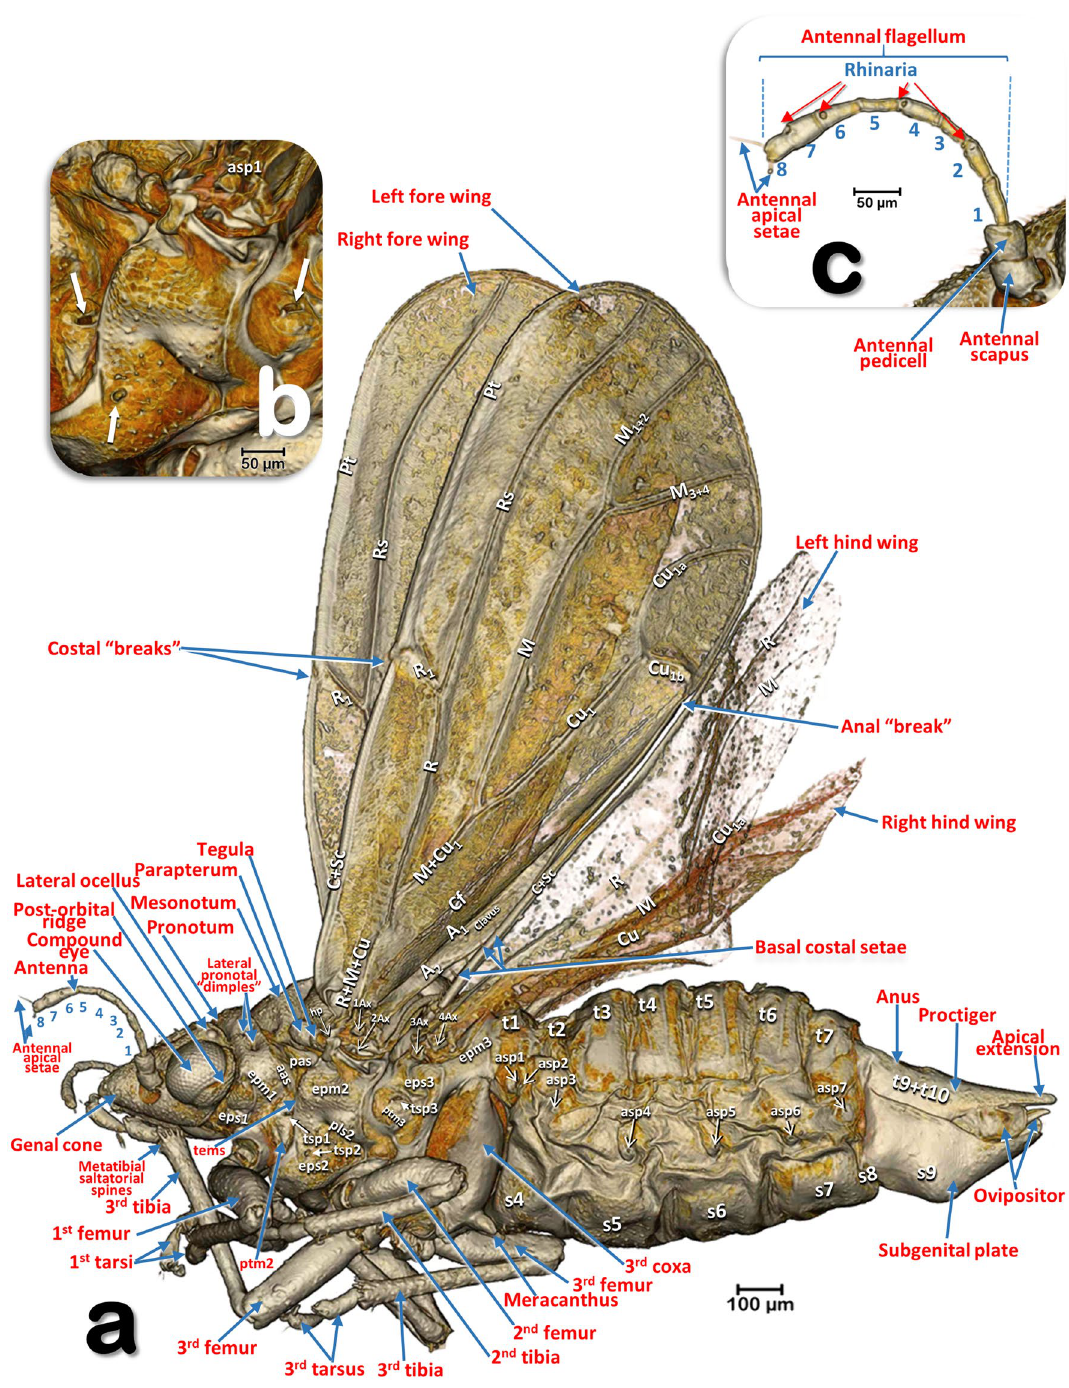
Figure 3. Volume-rendered images of an external left-lateral detailed view of a female Diaphorina citri ( a ) and a close-up detail of the pleural region of the thorax ( b ) (arrows indicate the spiracular openings), and the antenna ( c ). Abbreviations: A = anal vein; aas = anterior accessory sclerite; asp = abdominal spiracle; Ax =Axillary sclerite; C = costa vein; Cf = cubital fold; Cu = cubital vein; epm = epimeron; eps = episternum; hp = humeral plate; M = median vein; pas = posterior accessory sclerite; pls = pleural sulcus; Pt = pterostigma; ptm2 = mesothoracic peritreme; ptm3 = metathoracic peritreme; R = radius vein; Rs = radial sector vein; s = abdominal sternite; t = abdominal tergite; tems = transepimeral sulcus; tsp1 = prothoracic spiracle; tsp2 = mesothoracic spiracle; tsp3 = metathoracic spiracle. Abdominal tergites and sternites are labelled sequentially with the letter ‘t’ and ‘s’,